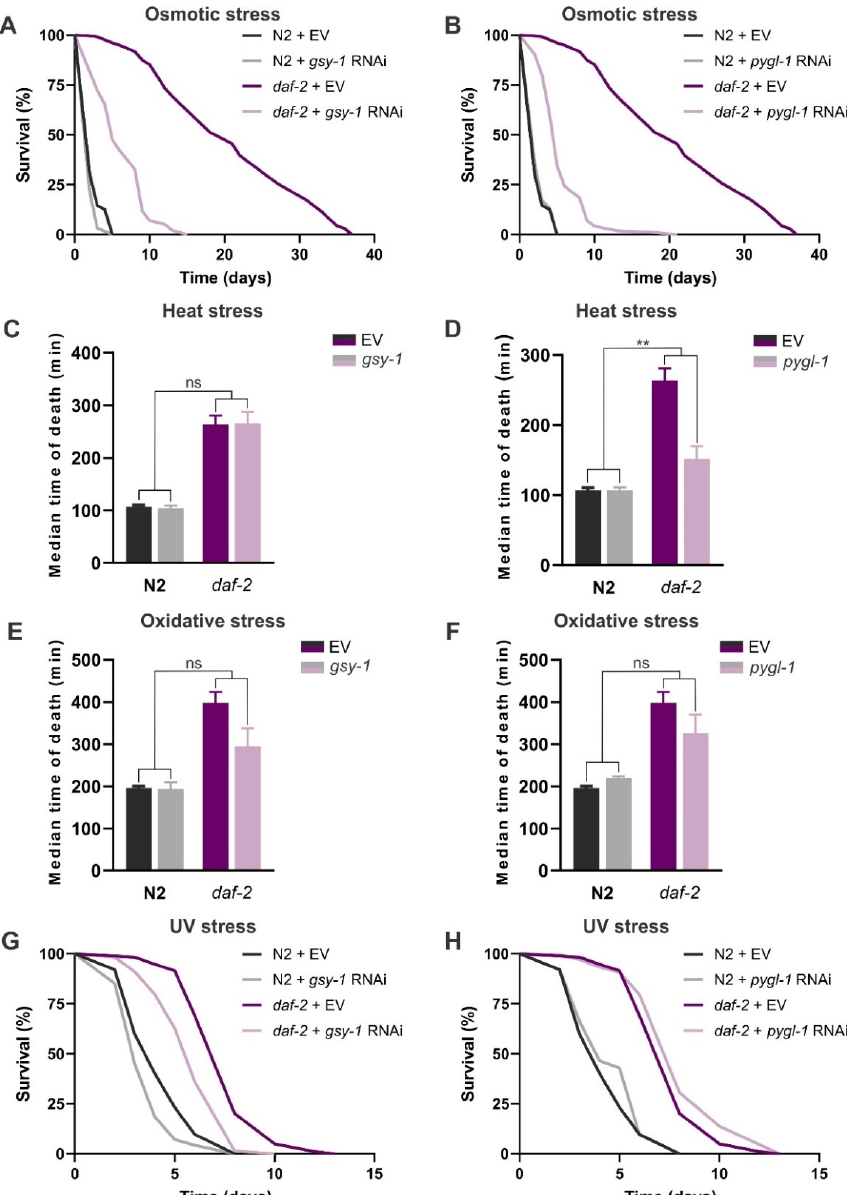
Figure 3. The role of gsy-1 and pygl-1 knockdown in stress resistance of wild-type N2 and daf-2(e1370) : ( A , B ) osmotic stress, 500 mM NaCl; ( C , D ) heat stress, 40 °C; ( E , F ) oxidative stress, 0.28% tert-butyl hydroperoxide (TBHP); and ( G , H ) UV stress (254 nm, 200 J/m 2 ). Survival curves in ( A , B ) represent pooled data from two biological replicates. Error bars in ( C – F ) indicate SEM of three in- dependent replicates. Survival curves in ( G , H ) depict pooled data from three independent trials. Survival data of all replicates are summarized in Tables S3–S6. EV—empty vector control. ns: p > 0.05, ** p ≤ 0.01 (RNAi*strain interaction, two-way ANOVA).